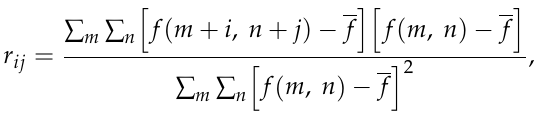
Figure 4. Visualization of a three-dimensional representation of the Pearson autocorrelation coefficient matrices: ( a ) raw and ( b ) filtered diagram.